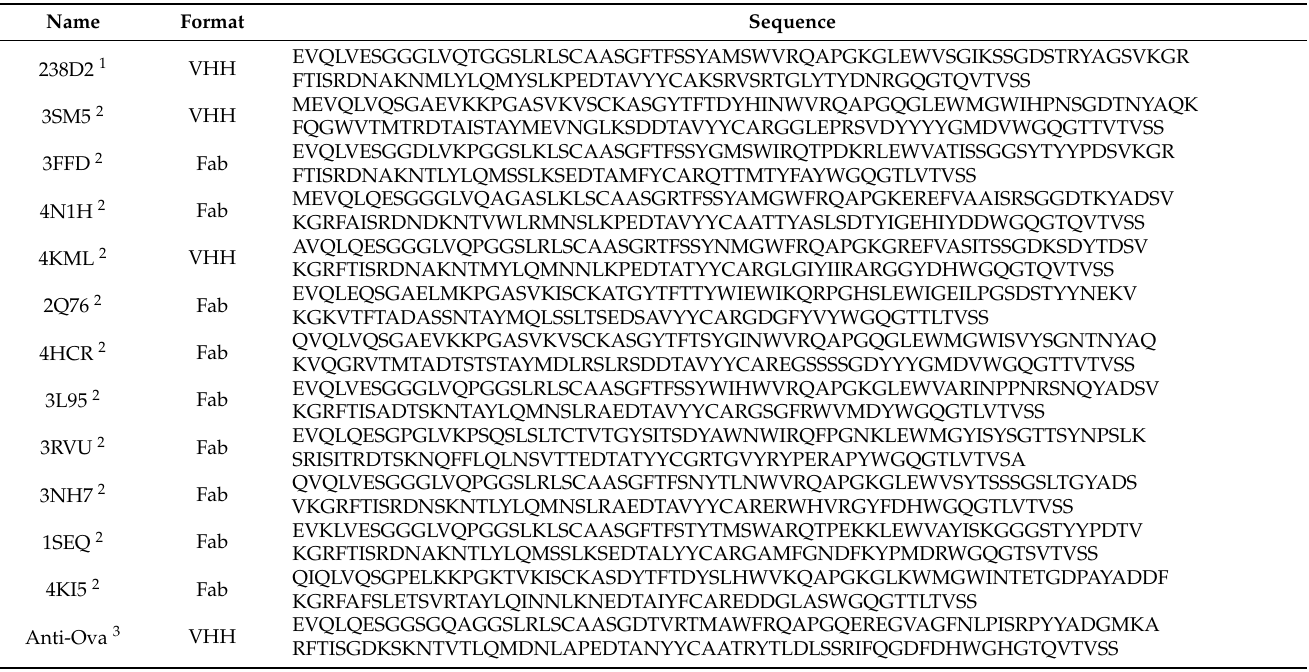
Table 3. Antibody